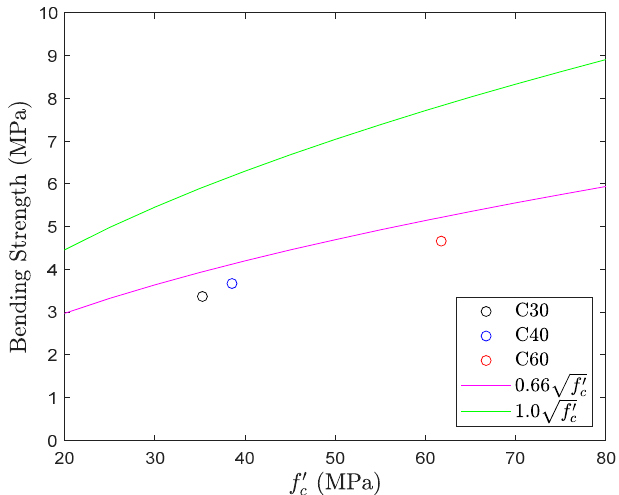
Figure 18. Tensile strength obtained from flexural test.